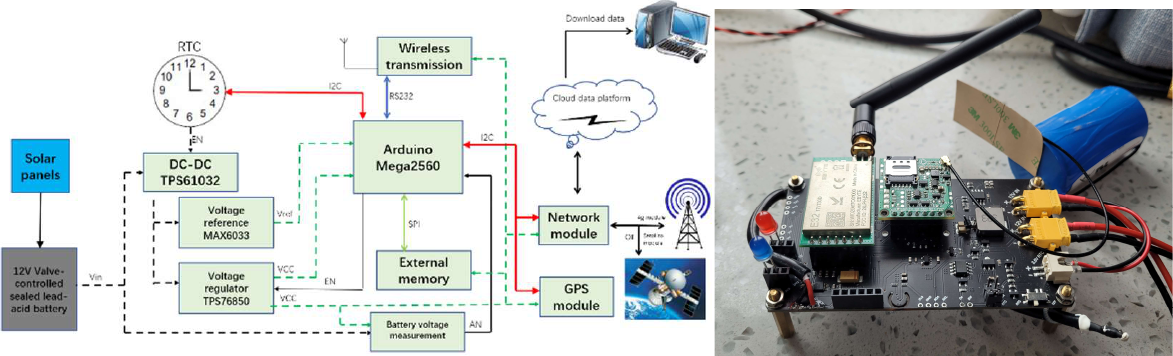
Figure 3. Structure diagram ( left ) and an example of the real sensors ( right ) for the glacier surface base station.